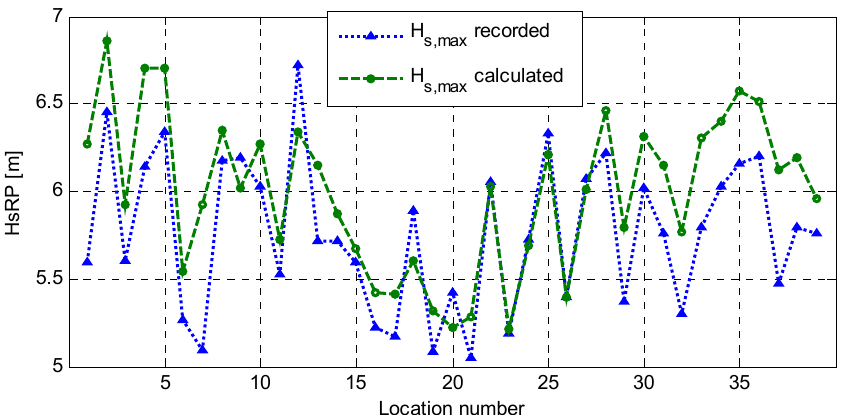
Figure 15. Hs comparison, per location, of most probable theoretical extreme and recorded maximum within WW database (duration 23.5 year).